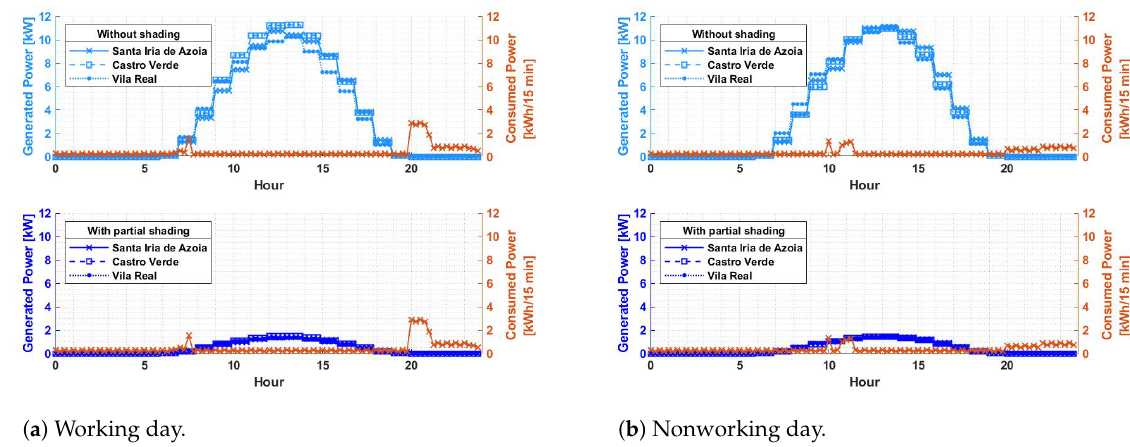
Figure 6. Generation and consumption curves on the two significant days of August for CIGS